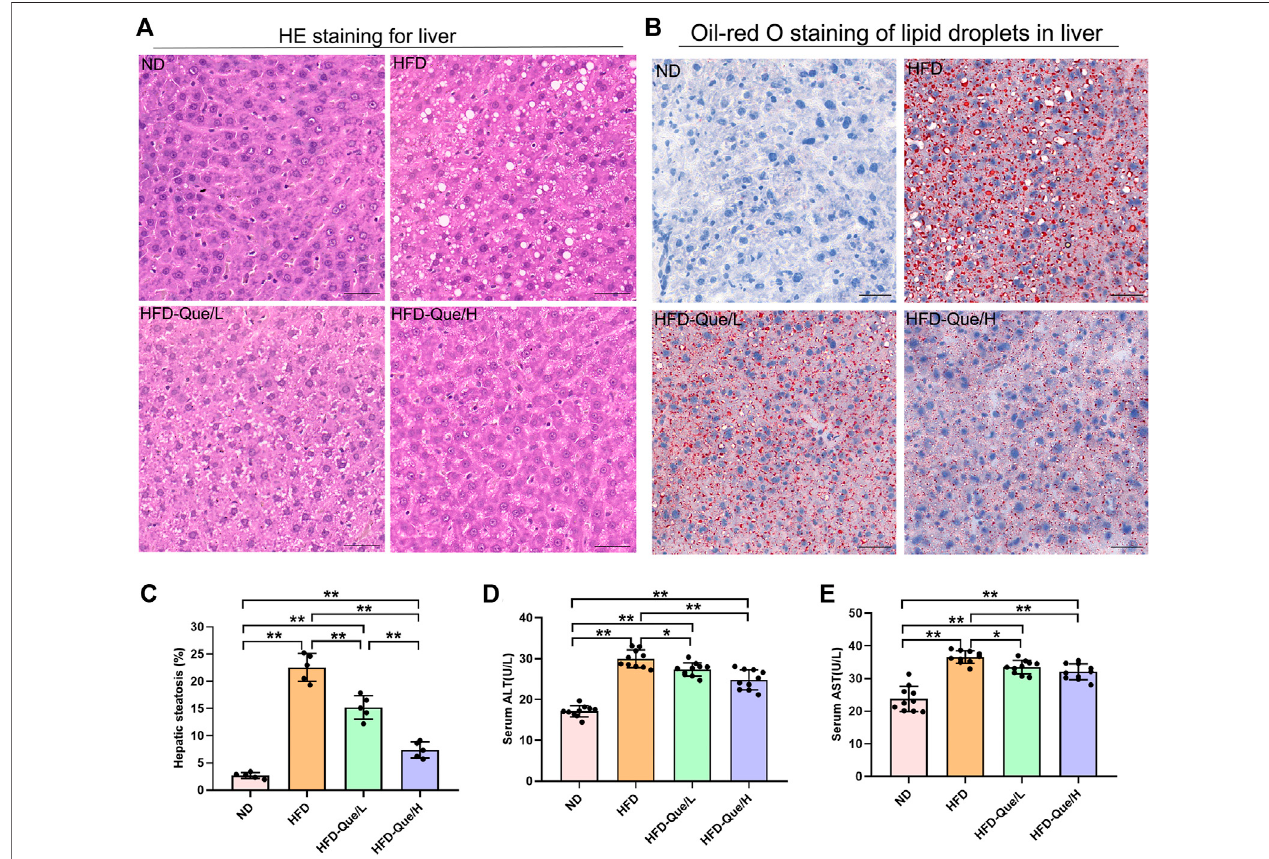
FIGURE2| Quealleviatedlipidaccumulationand hepatic injuryinHFD-fedmice. (A) Oil RedOstainingoftheliver(×200, scalebars =100 μ m). (B) H&Estainingof the liver (×200, scale bars = 50 μ m). (C) The quantitation of hepatic steatosis ( n = 5). (D) Serum ALT ( n = 10). (E) Serum AST ( n = 10). The data are expressed as the mean ± SD. **, p < 0.01 and *, p < 0.05.